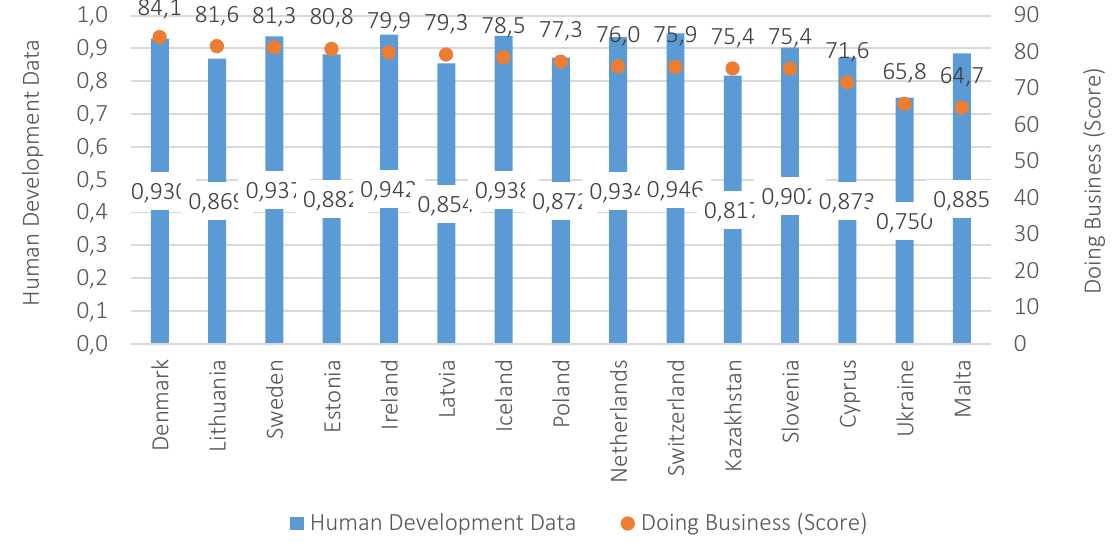
Human Development Data Doing Business Figure 3. Human Development Index and Doing Business in European countries in 2018 The analysis of the human development index and doing business in some European countries and Ukraine is presented in Figure 3. Based on the data in Figure 3, it is found an direct insignificant correlation between the human devel- opment index and the doing business indicator ( R 2 = 27.29%, the model is adequate to the observational evidence F = 4.88 > F = 4.75 and has signif- emp (0.05; 1; 13)